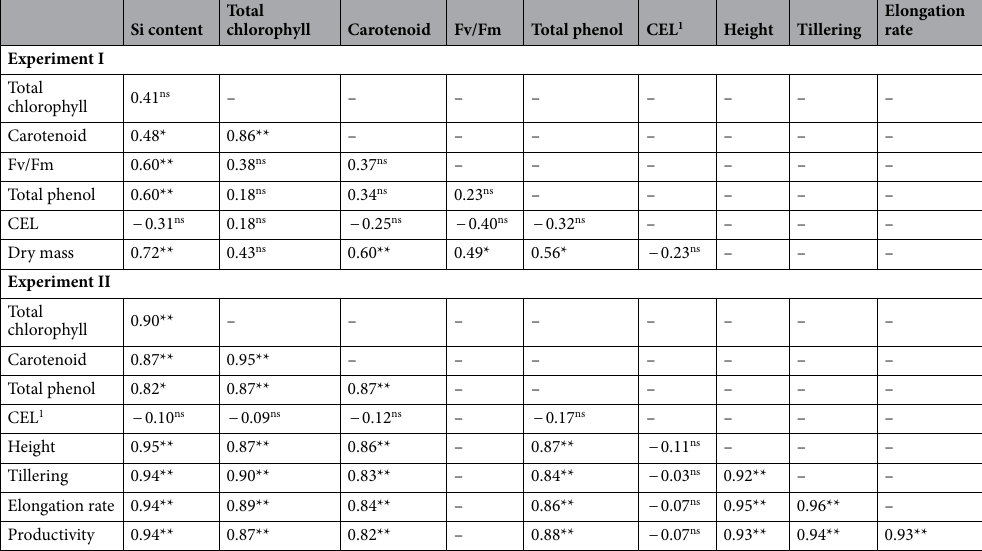
Table 1. Pearson correlation (p ≤ 0.05) between the variables analyzed regarding experiments I (PSS phase) and II (field phase). ns : p > 0.05. CEL 1 : cellular electrolyte